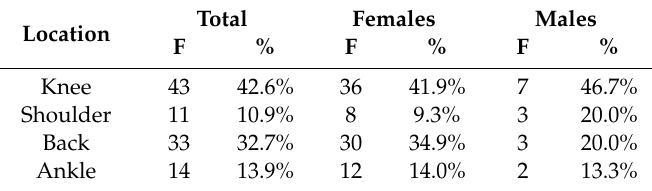
Table 2. Location of the musculoskeletal (MSK) injury / problem in hip hop dancers over the 3-month study period according to Oslo Sports Trauma Research Center Overuse Injury Questionnaire